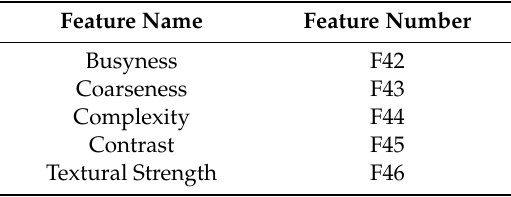
Table 8. Neighborhood gray tone di ff erence matrix feature sets.